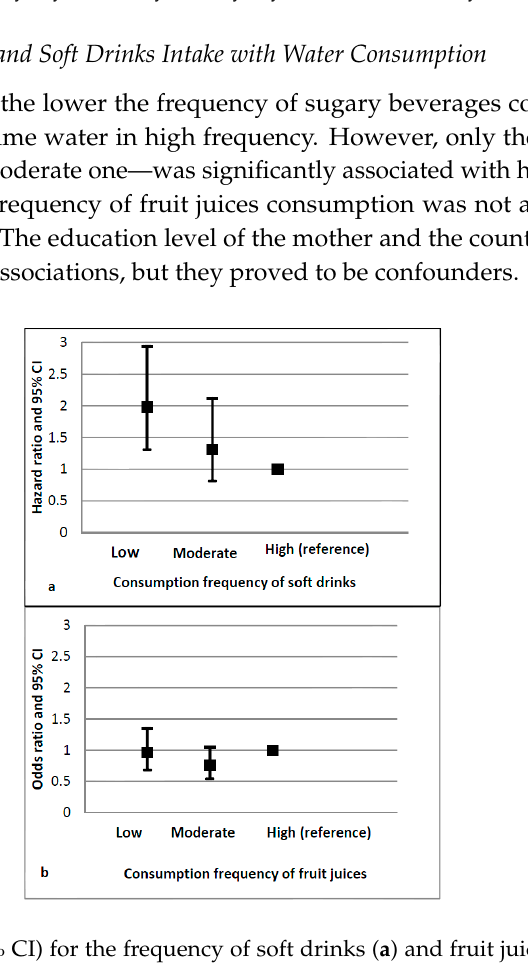
Figure 1. Odds ratios (95% CI) for the frequency of soft drinks ( a ) and fruit juices ( b ) consumption in relation to water consumption (high vs. low), adjusted for the country and educational level of the